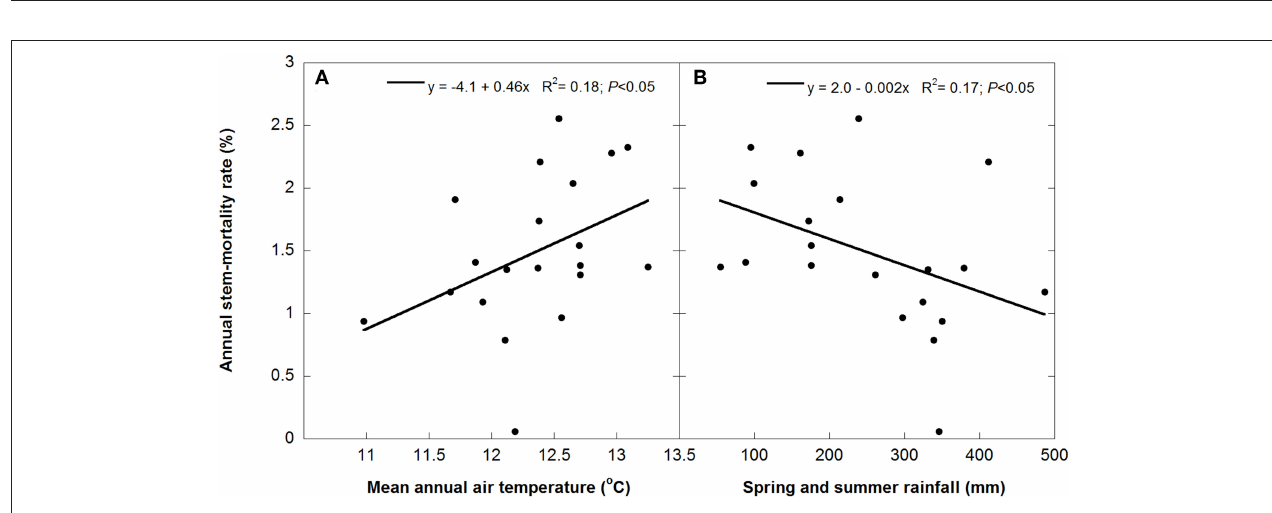
FIGURE 4 | Linear relationships between stem-mortality rates and mean annual temperatures (A) and rainfall during spring and summer (B) .